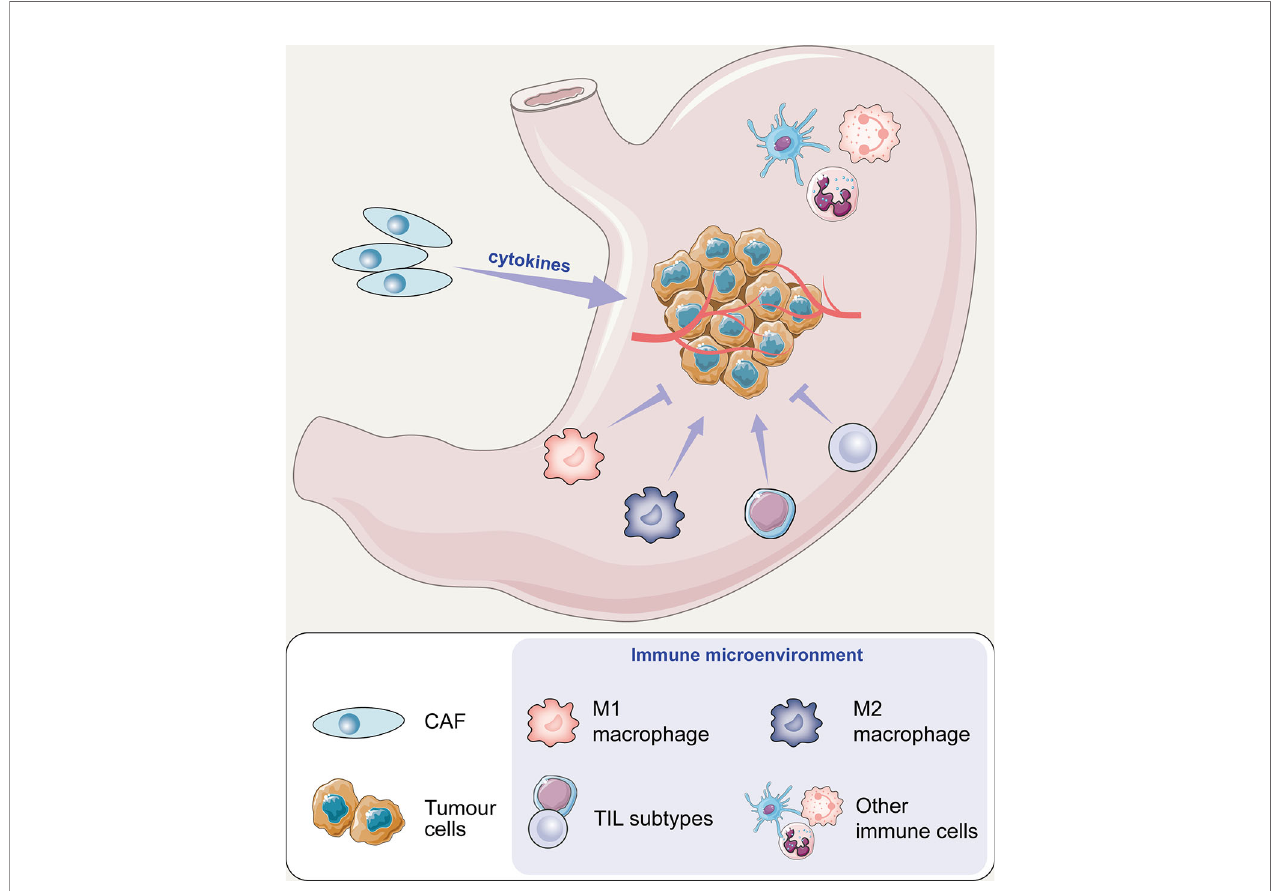
FIGURE 1 | The potential mechanism of cell action on tumours in the immune microenvironment of gastric